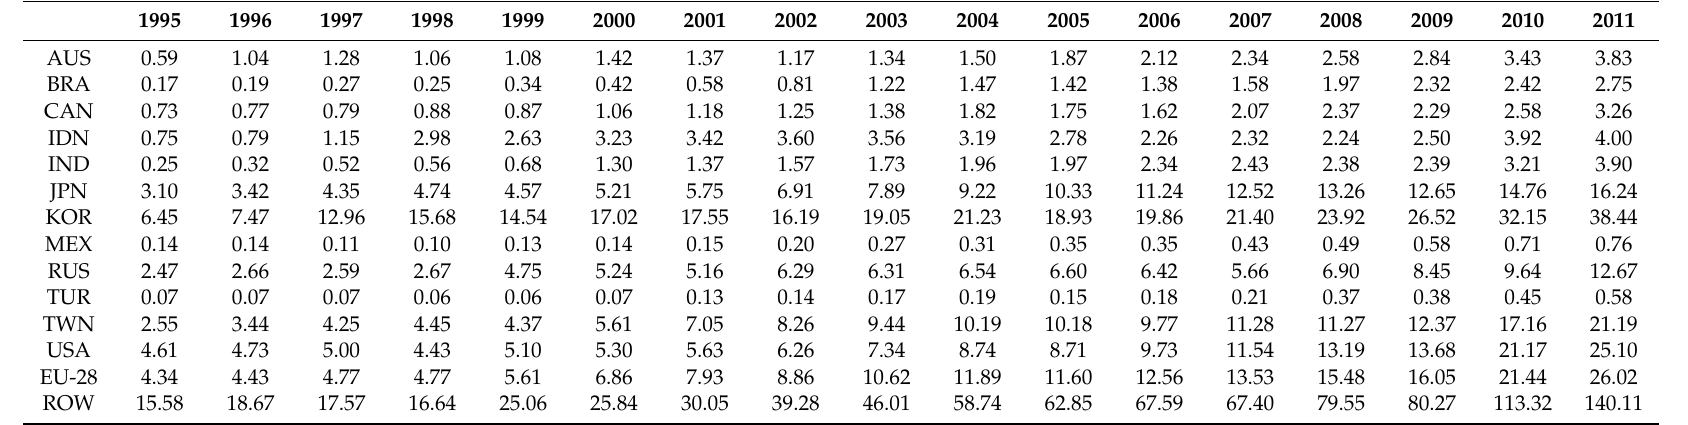
Table A3. China’s virtual oil imports